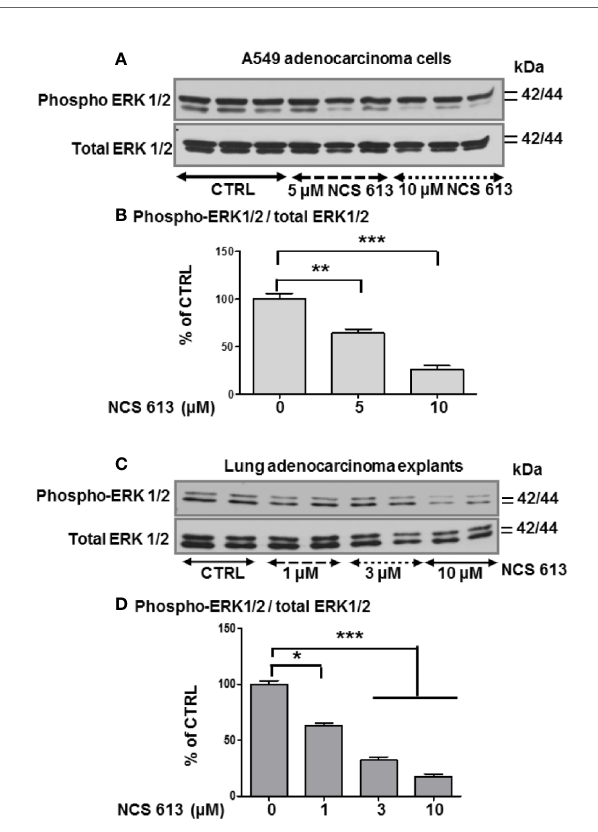
FIGURE 6 | Effect of NCS 613 treatment on ERK1/2 phosphorylation. (A, B) Concentration dependent effect of NCS 613 on the phosphorylation level of ERK1/2 as a function of experimental conditions (n=3); (C, D) Concentration dependent effect of NCS 613 on phospho-ERK1/2 detection in cultured lung adenocarcinoma explants (n=4). Unpaired Student ’ s t -test. Mean ± SEM. * p < 0.05, ** p < 0.01 and *** p <